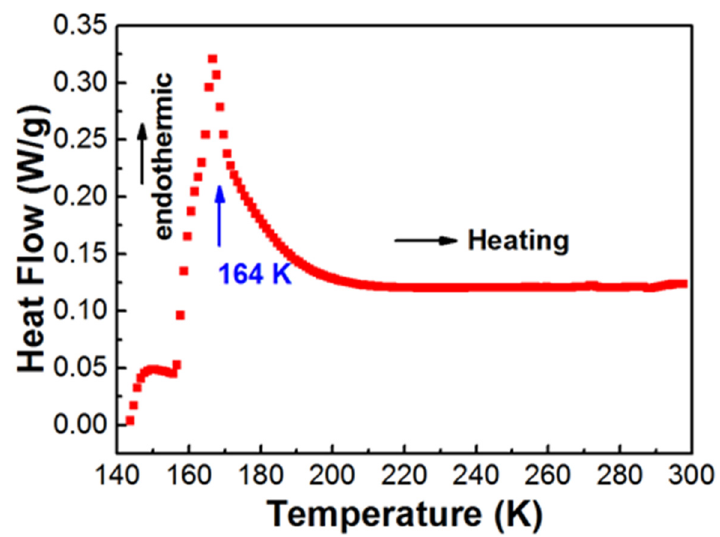
Figure 3. DSC curve of [(CH 3 ) 2 NH 2 ][Fe(HCOO) 3 ] at the heating rate of 5 K/min.